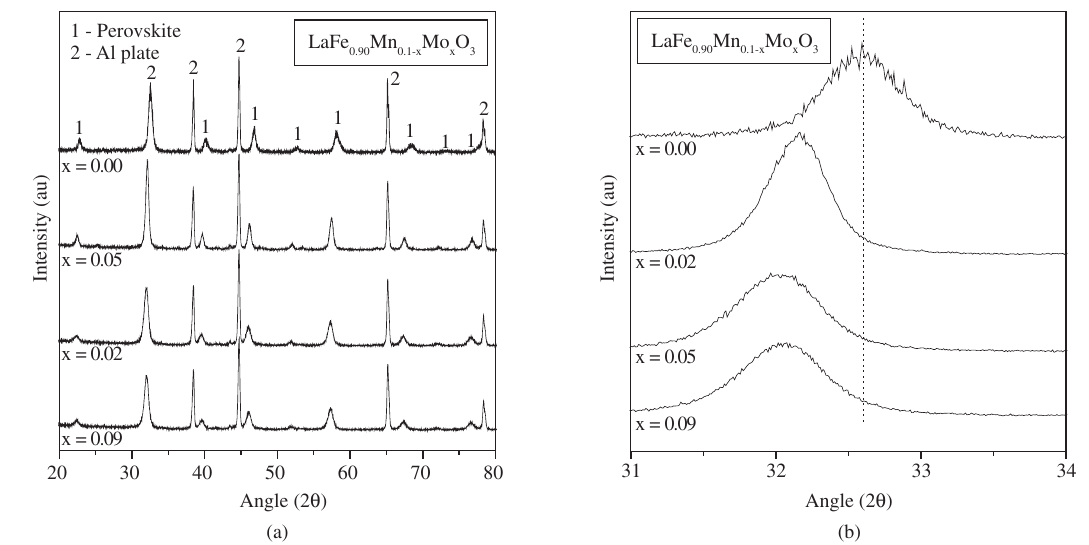
Figure 2. a) XRD of the different LaMn